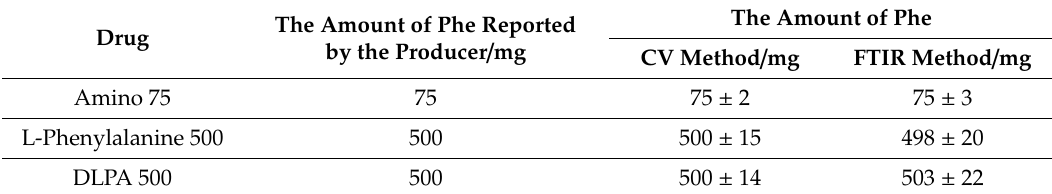
Table 3. The amount of L-Phe measured in pharmaceuticals products of di ff erent concentrations and di ff erent producers.